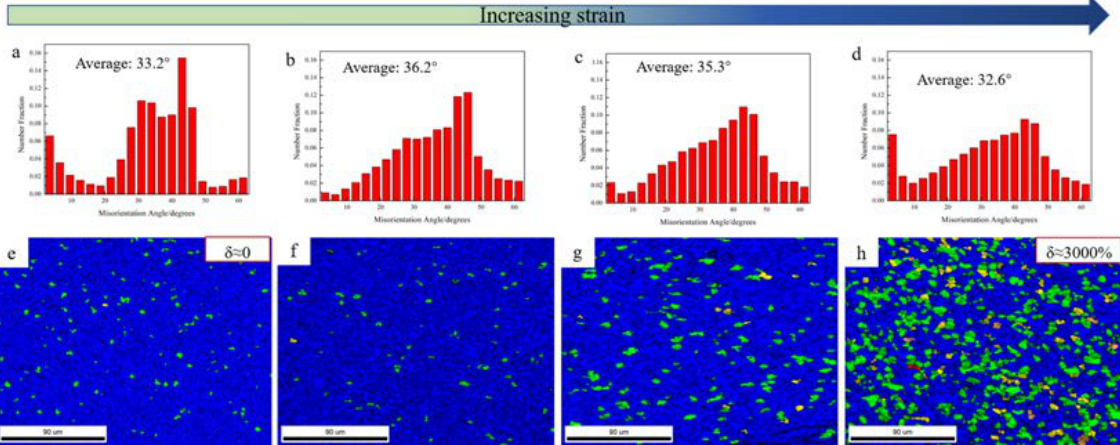
Figure 7. Misorientation angle charts and grain orientation spread maps of SP700 alloy at different positions at 760 °C: ( a , e ) the grip position, ( b , f ) the gauge section near the grip, ( c , g ) the middle of the gauge section, and ( d , h ) section near the tip of the fracture.